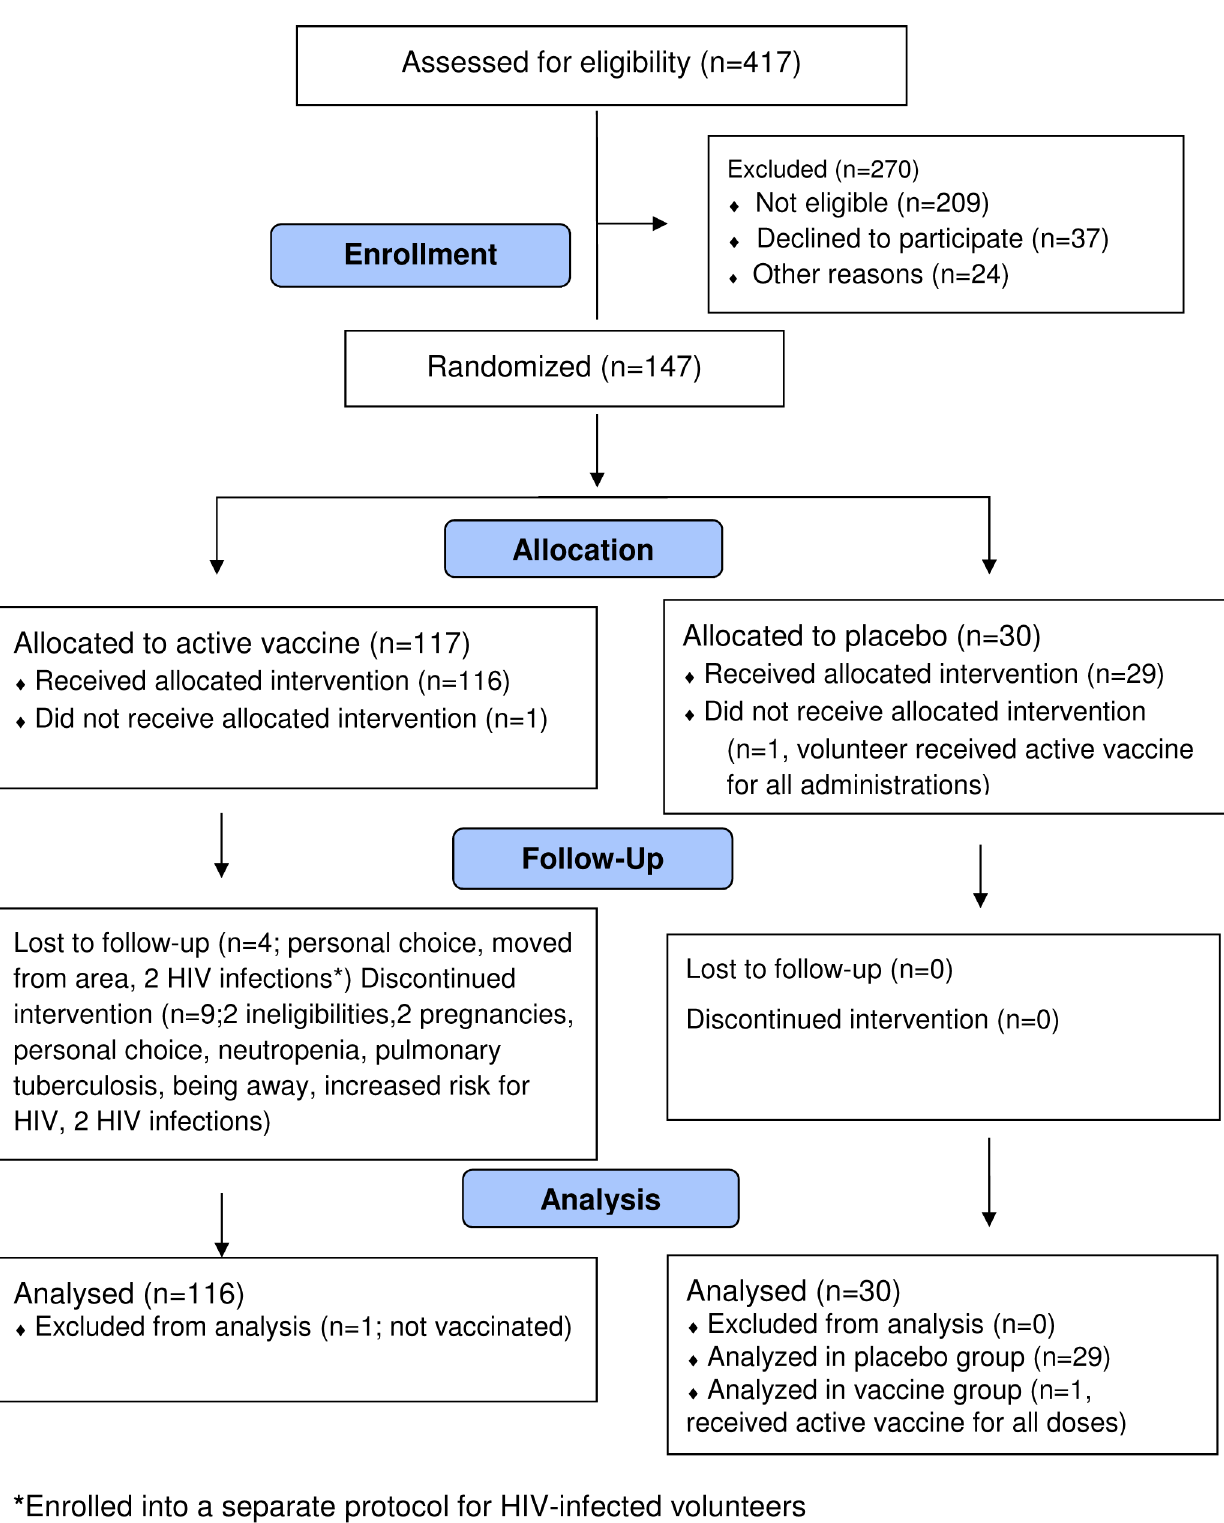
Fig 2. CONSORT Flow Diagram. Number of individuals assessed for eligibility, enrolled and randomized to study vaccine(s) and respective placebo, followed-up and analyzed.